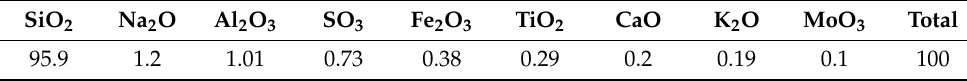
Table 2. Chemical composition analysis of the acid-leached residue (wt%).